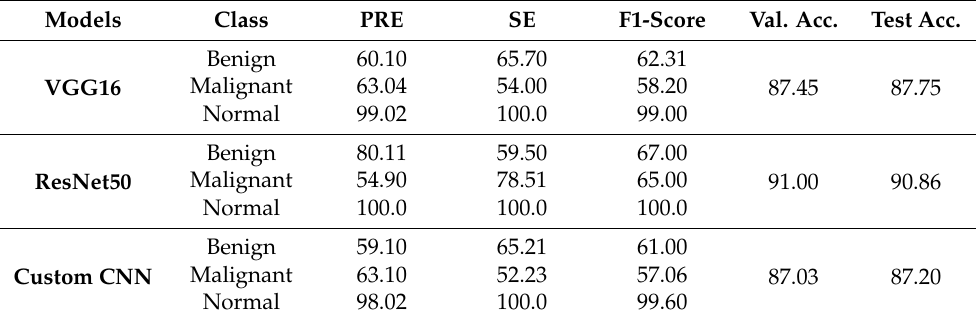
Table 9. Scenario B (Multi-class classification) evaluation performance (%) via three AI models using Dataset 2 (256 × 256 patches) without